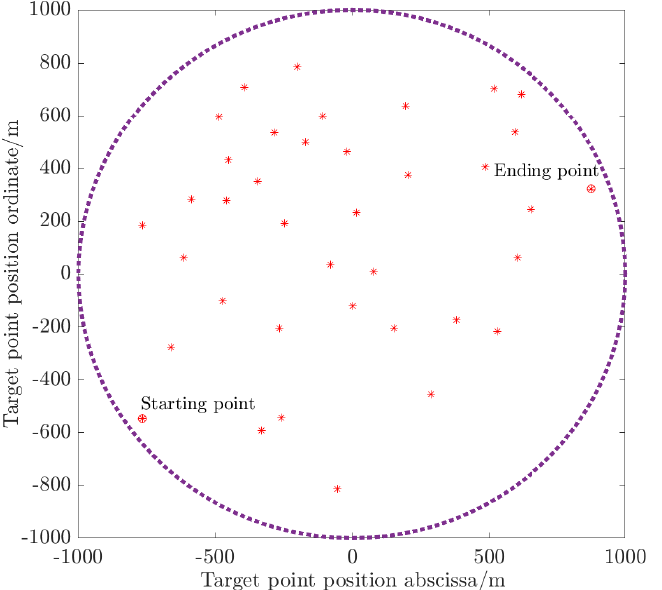
Figure 4. Region of search and possible targets.